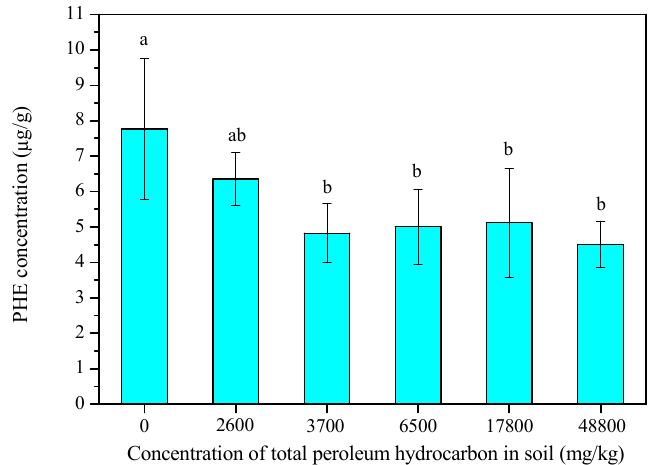
Figure 5. Phenanthrene concentration of maize leaf in different treatments. ( p < 0.05). Different letters on top of the bar indicate they are significantly different at p < 0.05.